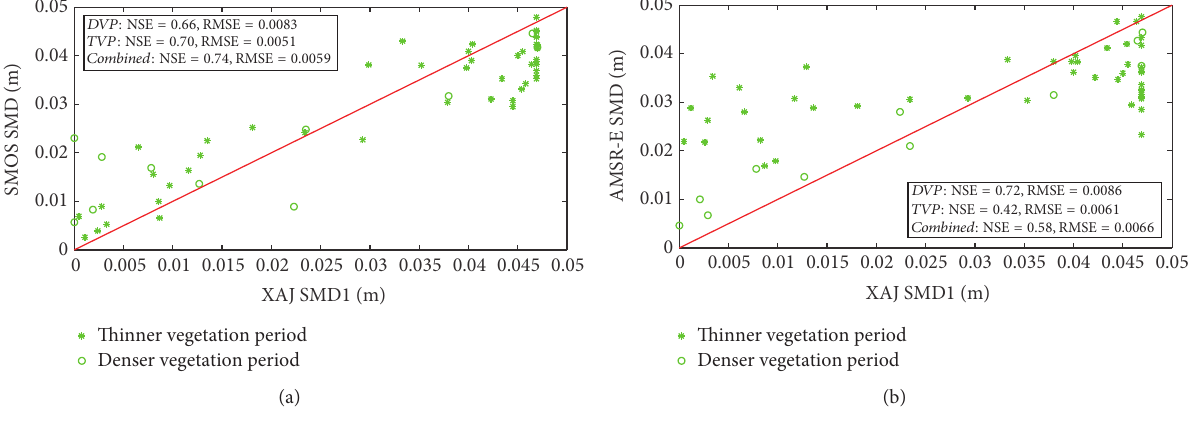
Figure 9: For PB basin, leave-one-out cross-validation results of SMDs derived from the two satellite soil moisture products (SMOS and AMSR-E) against XAJ SMD1: (a) SMOS and (b) AMSR-E. DVP stands for denser vegetation period and TVP means thinner vegetation period. It is noted that all RMSEs shown here are in the unit of